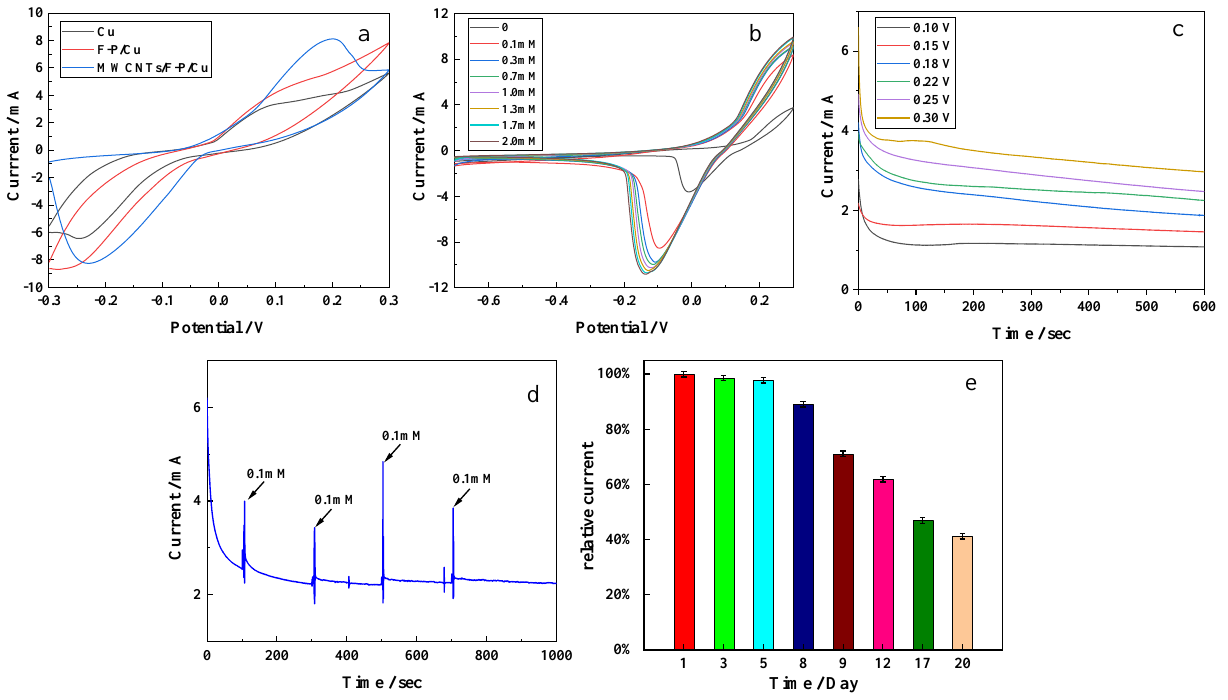
Figure 5. Electrochemical characterization of the fabricated anode. ( a ): CV curves of Cu electrodes with different modifications (bared Cu, F-P/Cu, MWCNTs/F-P/Cu). ( b ): CV curves of the fabricated electrode (GOx/MWCNTs/F-P/Cu) in glucose solution of different concentrations. ( c ): Chronoam- perometry curves of the fabricated electrodes (GOx/MWCNTs/F-P/Cu) at different potentials. ( d ): Chronoamperometry curve of the fabricated electrode at best potential (0.25 V); ( e ): Maximum cur- rents of the fabricated electrodes after several days in indoor environment.